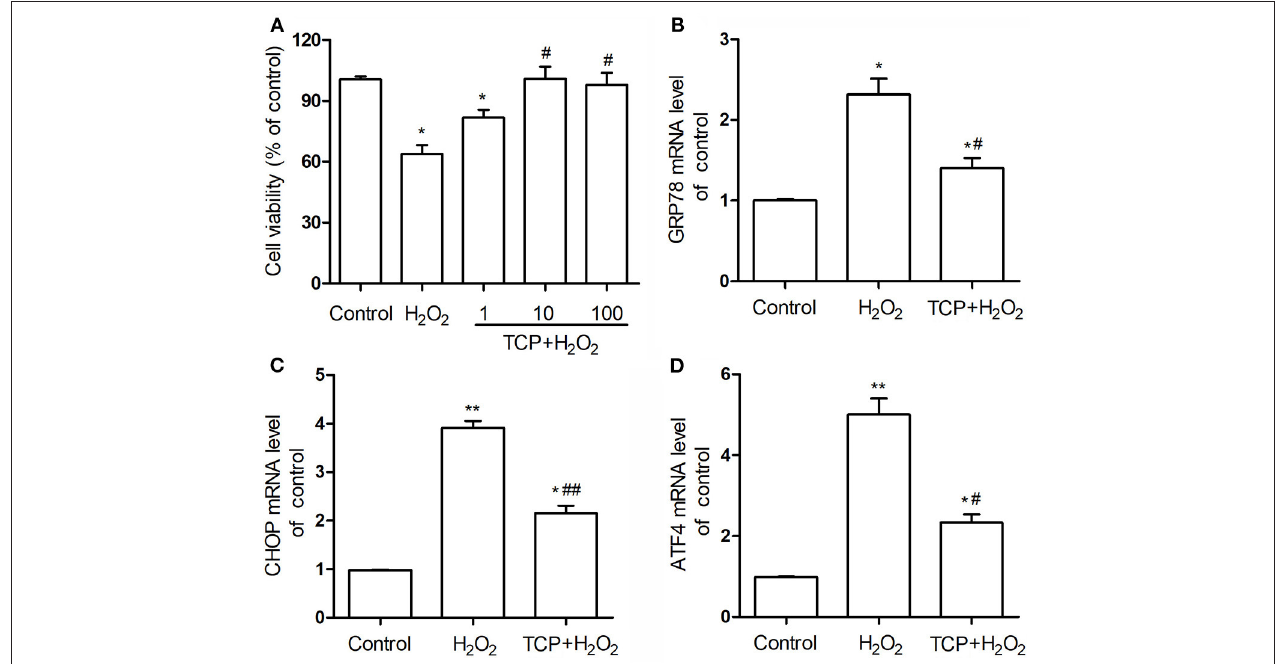
FIGURE 4 | Cell viability (A) of TCP-protected HUVECs with different TCP concentrations (1, 10, and 100 µ g/mL) and mRNA expression levels of GRP78 (B) , CHOP (C) , and ATF4 (D) of 10 µ g/mL TCP-protected HUVECs against H 2 O 2 -induced injury. The data are expressed as the means ± SD. Statistically significant differences among different groups: * P < 0.05, ** P < 0.01, compared to the control group; # P < 0.05, ## P < 0.001, compared to the H 2 O 2 group. TCPs in tuna head soup at the boiling time of 150min were applied in this